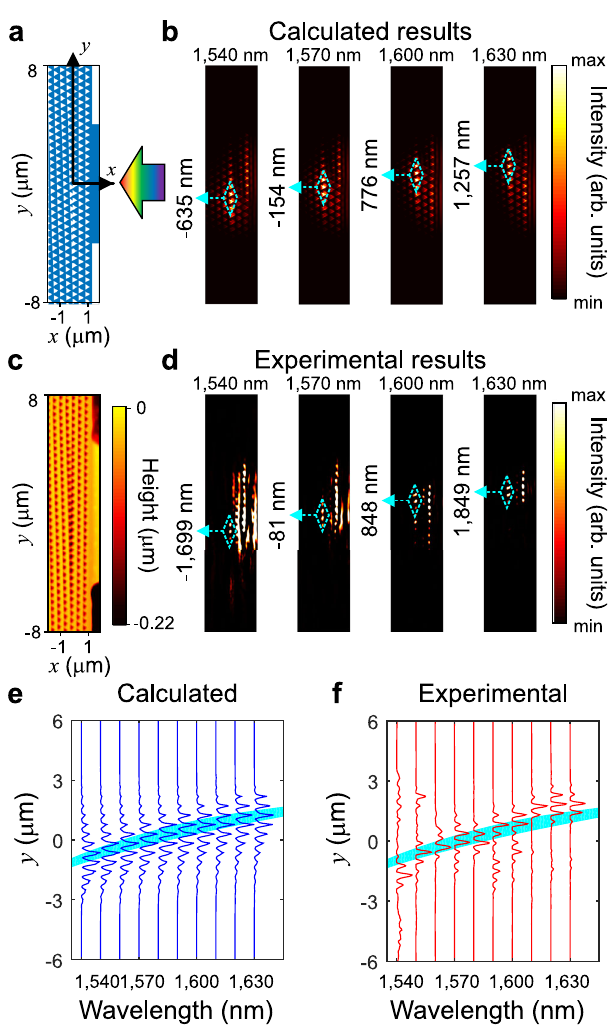
Fig. 4 Calculated and experimental results of the topological rainbow. a The top view of the FDTD model, where coordinate axes are marked and light is incident from the waveguide. b The light intensity distributions (|E| 2 ) of the calculated results for different wavelengths. c The topographic image of the sample. The color denotes the height of the surface of the sample. d The light intensity distributions of experimental results for different wavelengths. The comparison between interface intensity and projected bands for calculated ( e ) and experimental ( f ) results. In b , d , the position with maximal intensity is marked by the cyan dashed rhombuses, and the corresponding y coordinates are marked in the left. The wavelength of incident light is marked on the top of each fi